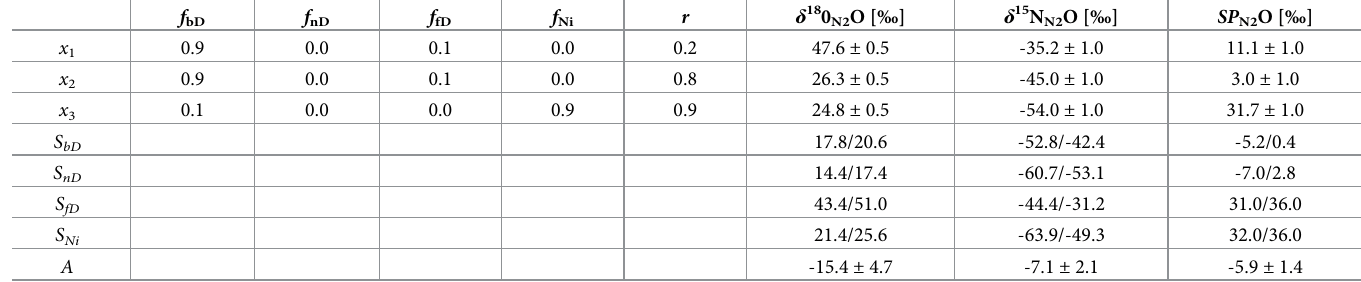
Table 10. Summary of input data for the FRAME model: 3 samples ( x 1 , x 2 , x 3 ) of different sources and reduction contribution, 4 sources (given as range from/to) and auxiliary parameter representing the reduction fractionation